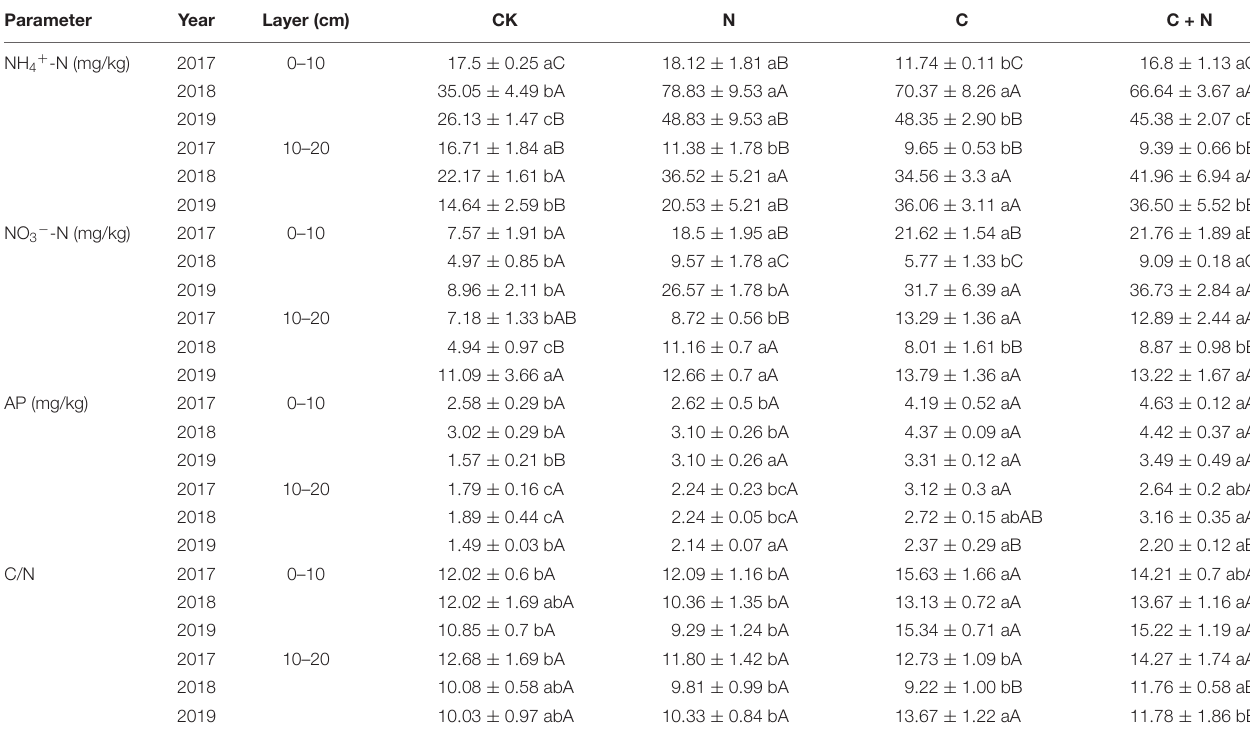
Values are means ± SE, lowercase letters indicate differences between different treatments in the same year (P < 0.05), and uppercase letters indicate differences between different years in the same treatment (P < 0.05).